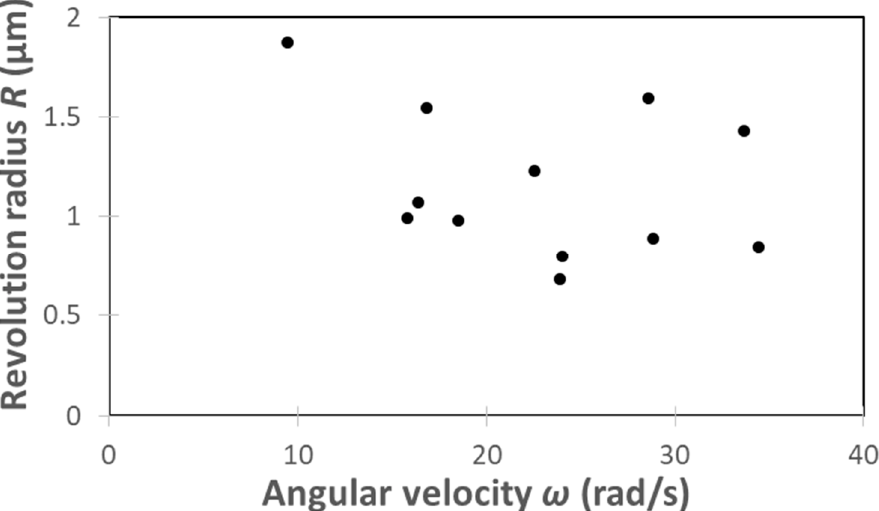
Figure 13. Distribution of angular velocity and revolution radius.